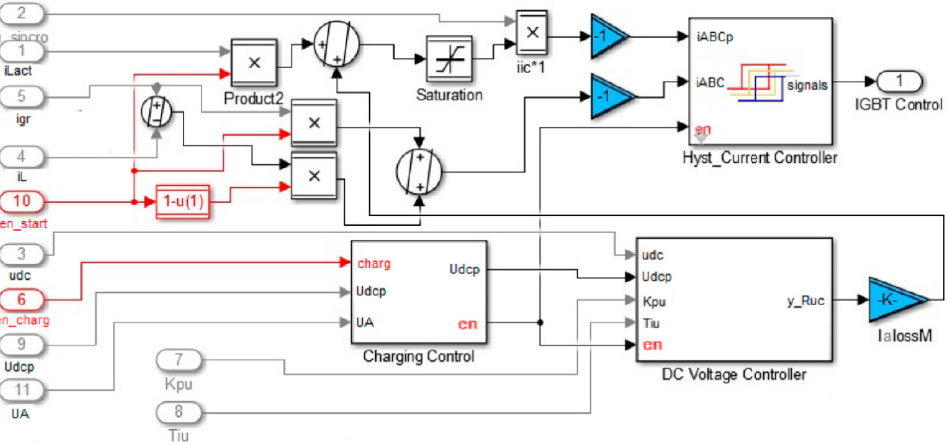
Figure 11. The structure of the SAPF control.